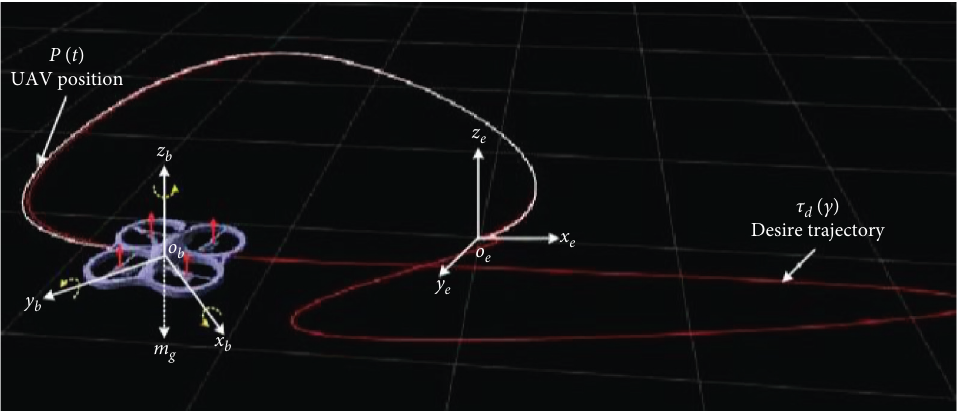
Figure 1: Trajectory tracking